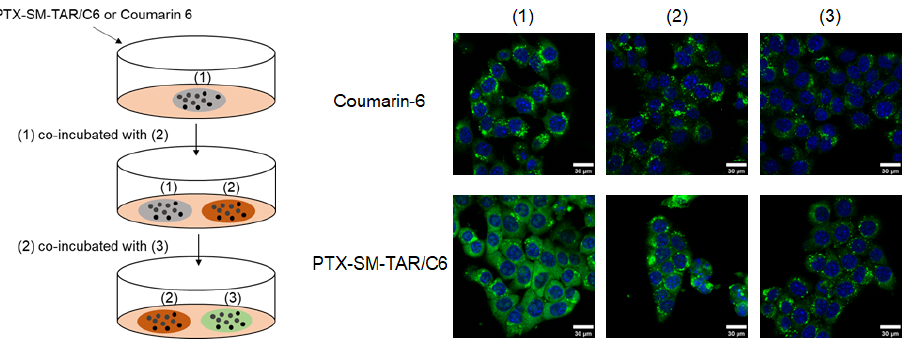
Figure 6. Intracellular migration of PTX-SM-TAR/C6 NPs and coumarin-6 visualized by LSCM. The cell nuclei were stained with DAPI (blue), and the PTX-SM-TAR NPs were dyed with coumarin-6 (green). The scale bar is 30 μ m.